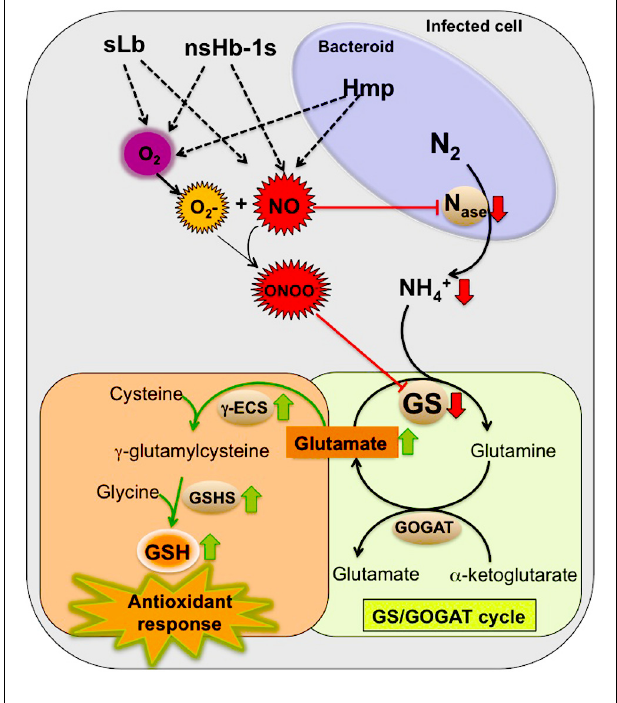
FIGURE 2 | Proposed model for the involvement of GS in the NO signaling events in root nodules by contributing to the nodule antioxidant responses. Red arrows indicate down regulation by NO and the green arrows indicate up regulation by NO. Enzymes: nitrogenase (Nase), glutamine synthetase (GS), glutamate synthase (GOGAT), γ -glutamylcysteine synthetase ( γ -ECS) and glutathione synthetase (GSHS). Hemoglobins: symbiotic leghemoglobin (sLb), class 1 non-symbiotic hemoglobins (nsHb-1s), rhizobial flavohemoprotein